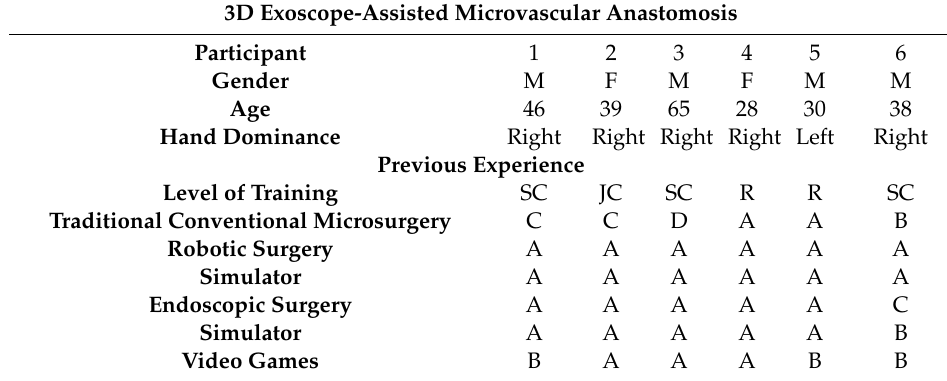
Table 1. The surgeons’ demographic data are reported. Level of Experience: A Novice, B advances beginner, C Competent, D expert. Level of Training: SC: Senior Consultant. JC : Junior Consultant. R :